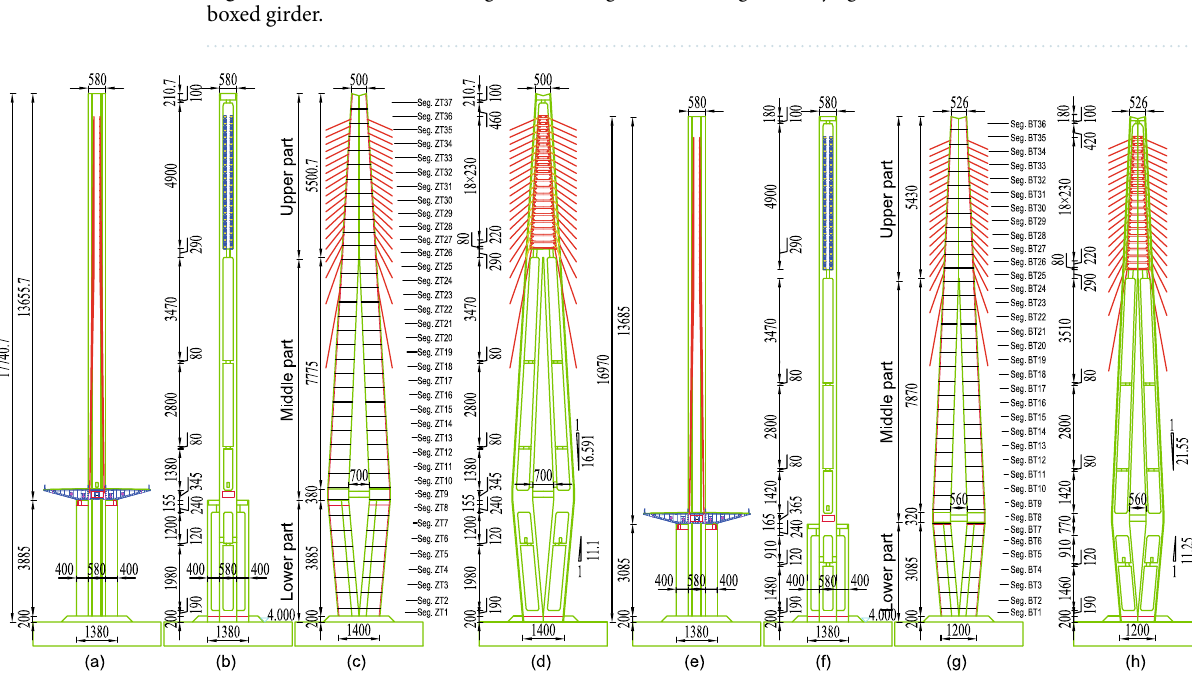
Figure 2. Middle pylon and side pylon structure layout. ( a ) middle pylon in the transverse direction layout; ( b ) middle pylon in the transverse direction profile layout. ( c ) middle pylon in the longitudinal direction layout; ( d ) middle pylon in the longitudinal direction profile layout. ( e ) side pylon in the transverse direction layout; ( f ) side pylon in the transverse direction profile layout; ( g ) side pylon in the longitudinal direction layout; ( h ) side pylon in the longitudinal direction profile layout.